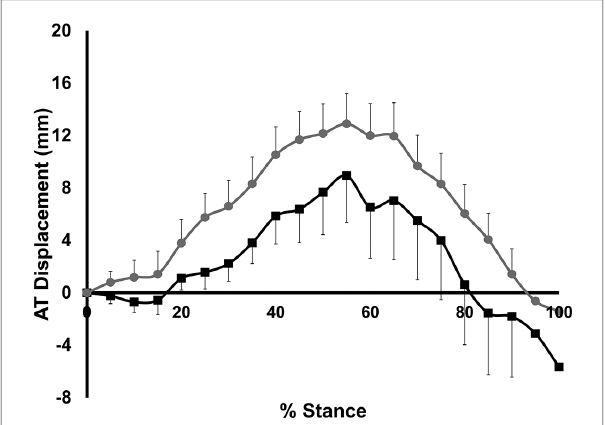
FIGURE 3 Time-normalized AT displacement over the stance phase of running relative to the AT length measured at heelstrike. Values are presented as mean±SD. Grey circles represent the SHORT AT MA group, while black squares represent the LONG AT MA group.